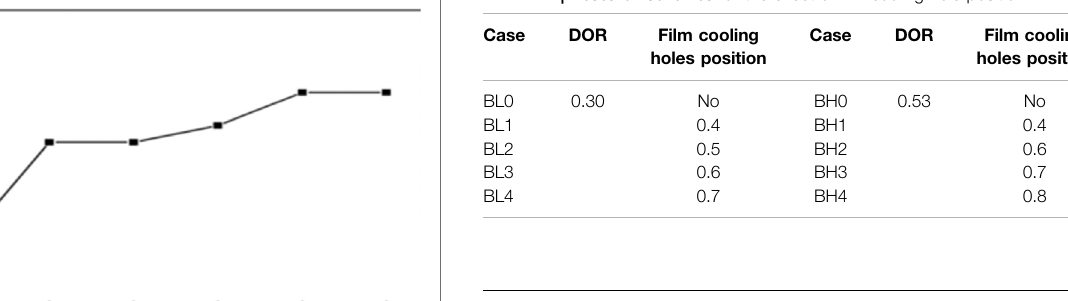
TABLE 2 | Research schemes for the effect of various coolant mass fl ow